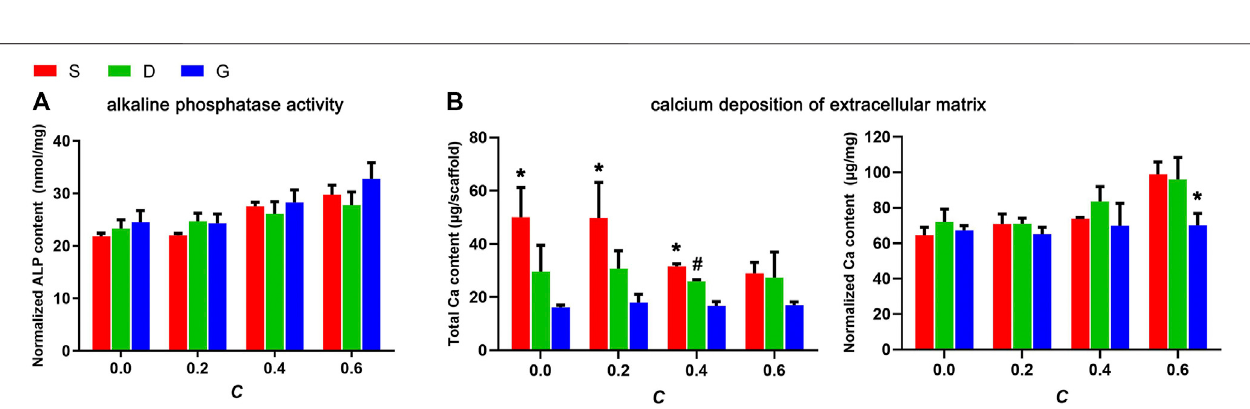
FIGURE 12| (A) The ALP activity of rMSCs on scaffolds after 10 days of osteogenic induction culture and, (B) The ECM mineralization of rMSCs on scaffolds after 14 days of osteogenic induction culture ( n = 3, * indicates signi fi cant differences compared with the other two groups, # indicates signi fi cant differences compared with the G group, p <